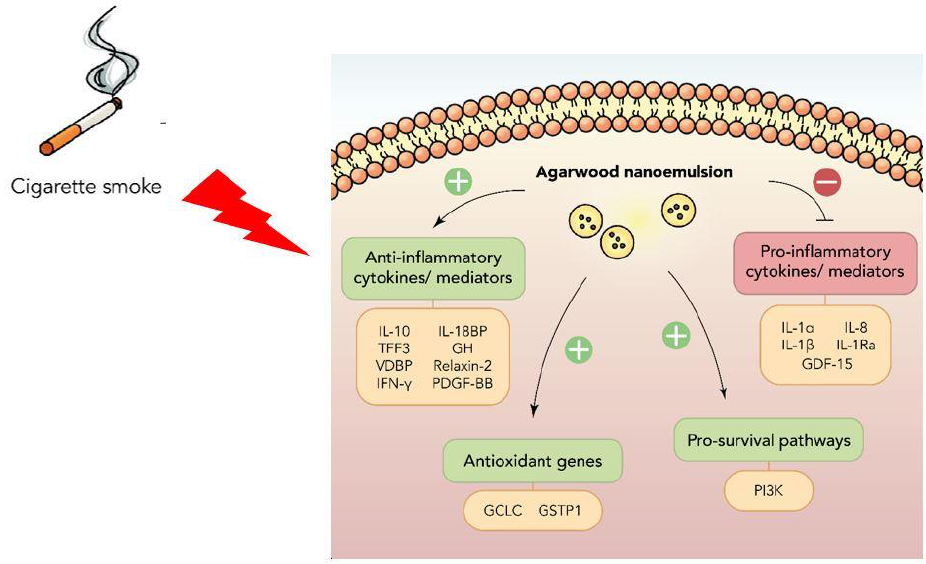
Figure 7. Summary of the anti-inflammatory and antioxidant molecular pathways activated by agarwood-NE to counteract the effect of cigarette smoke extract in BCi-NS1.1 cells.